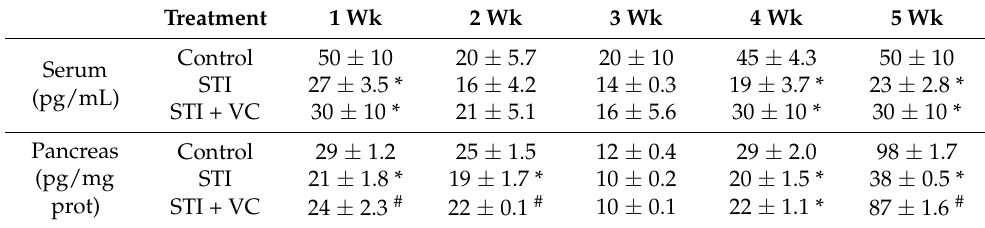
Table 8. Change of SST levels in serum and